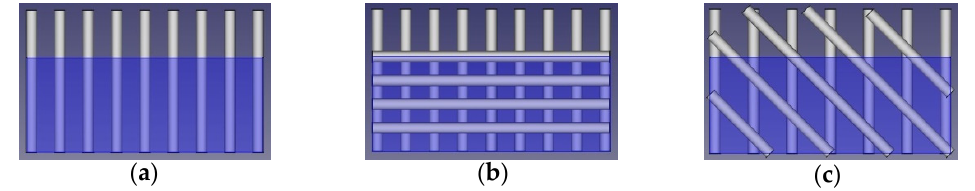
Figure 2. The formation in placing bamboo pile breakwater. ( a ) Vertical only formation (VO), ( b ) the combination between vertical poles and horizontal poles, and ( c ) the combination between vertical poles and diagonal poles.